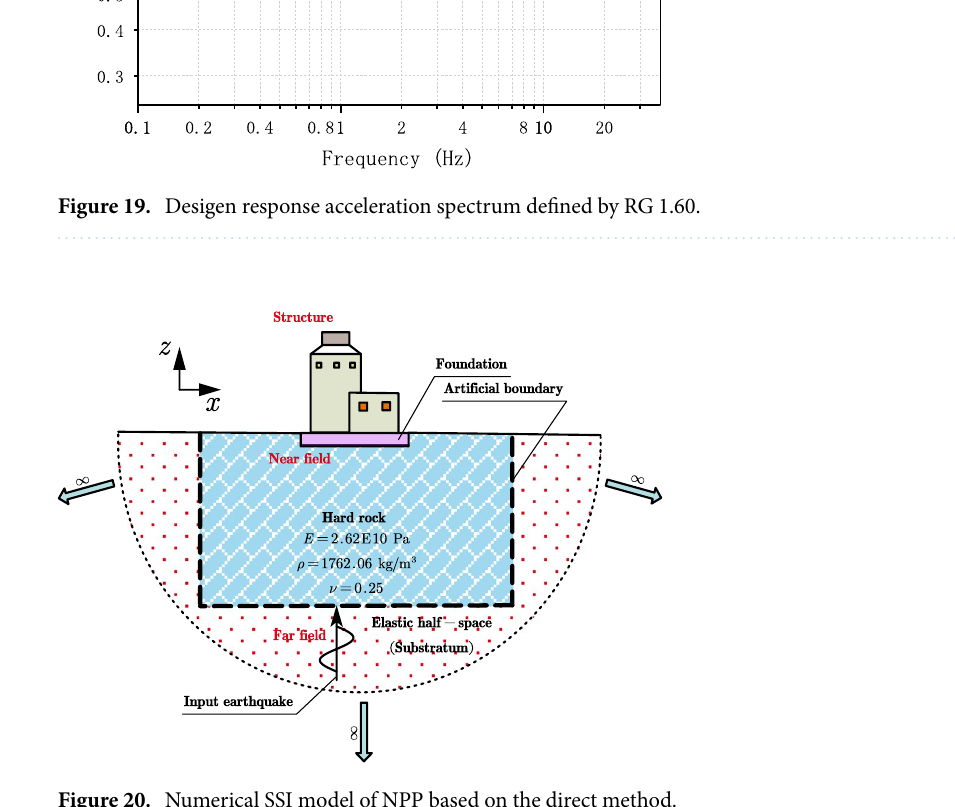
Figure 20. Numerical SSI model of NPP based on the direct